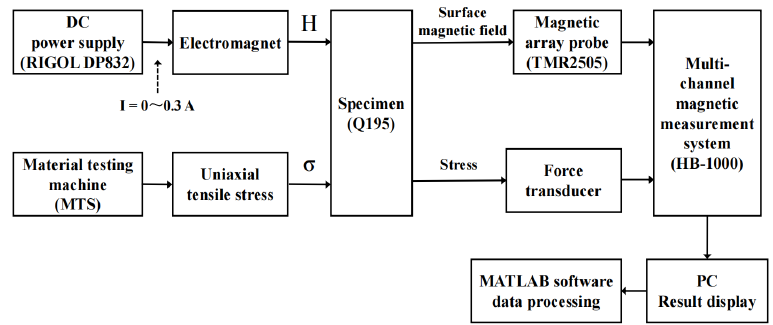
Figure 3. Block diagram of the measurement system.